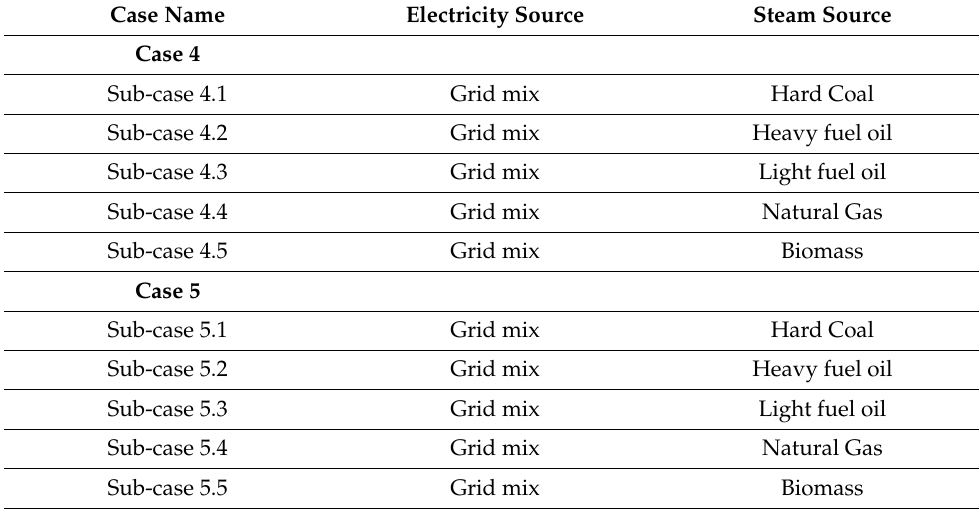
Table 6. Sub-cases considered in the LCA study.